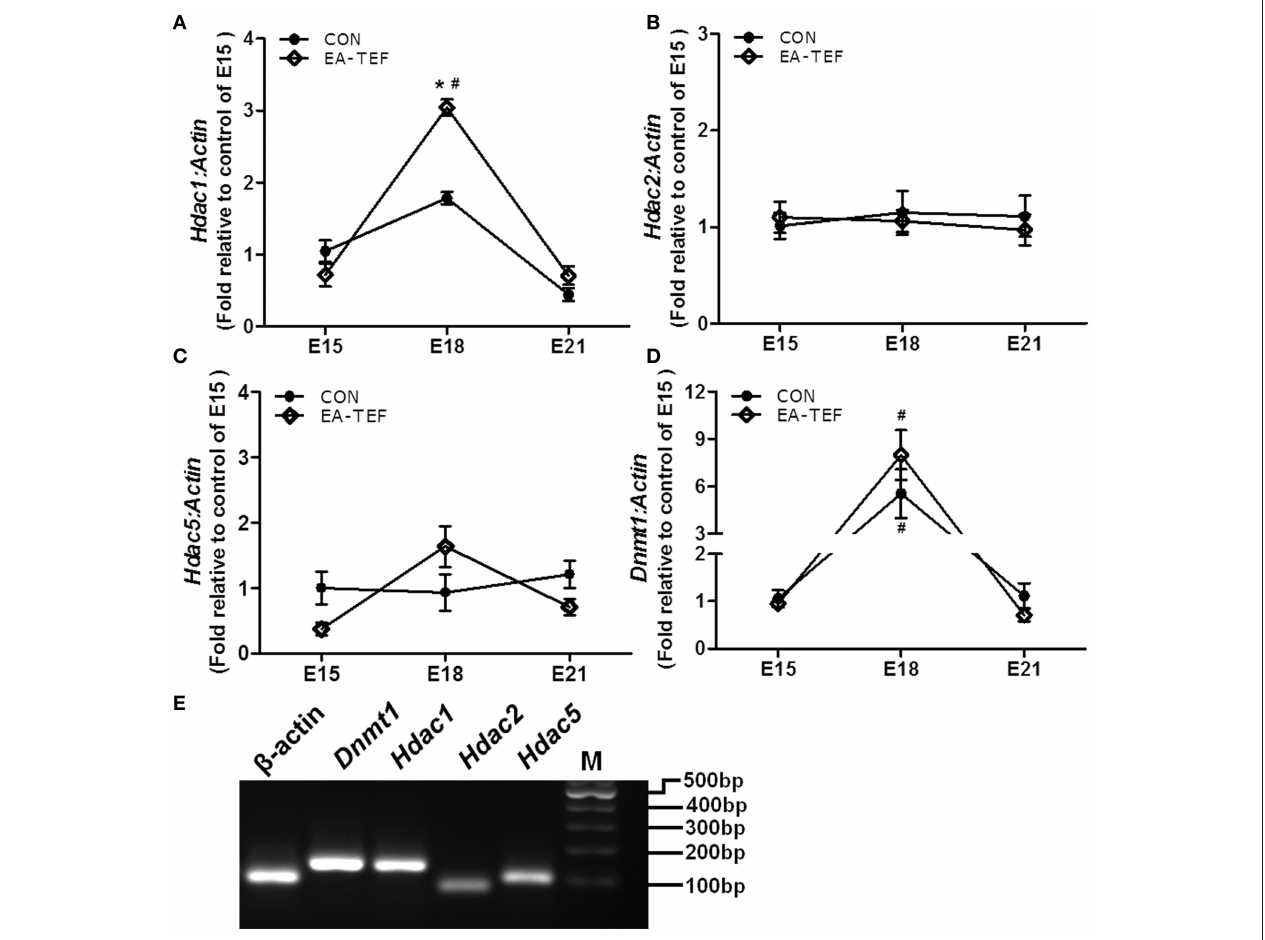
FIGURE 6 | Effect of doxorubicin on expression epigenetic regulatory factors in fetal lungs. (A–D) Dnmt1 , Hdac1, Hdac2 , and Hdac5 mRNA expression were determined by quantitative PCR relative to E15. (E) the specificity of the PCR products was confirmed visually on 2% agarose gels. Data are means ± SEM, * P < 0.05, EA-TEF vs. age-matched controls, between group; # P < 0.05, E18 or E21 vs. E15, within group.